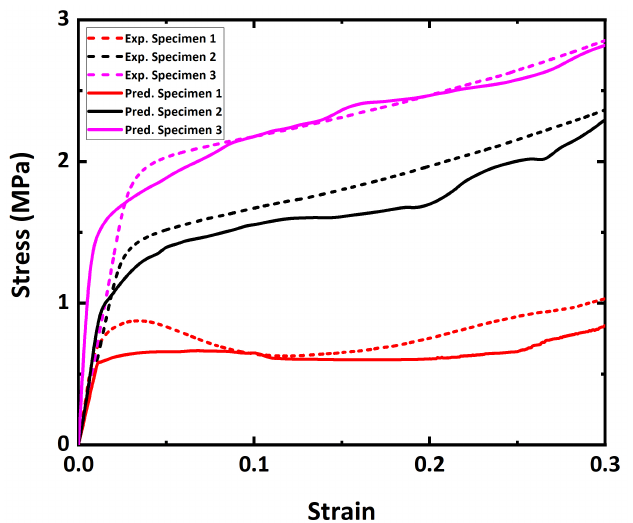
Figure 7. Comparison of stress–strain curves between experiments and predictions of various Figure 7: Comparison of stress-strain curves between experiments and predictions of various Ni Ni foams